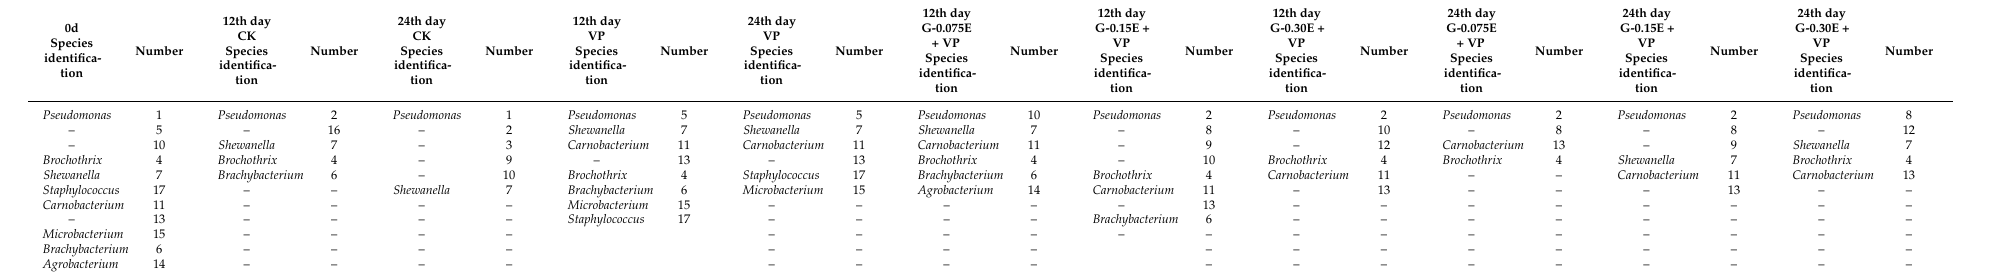
Table 4. Identification of bacteria isolated from various seabass fillet samples during cold storage at − 0.9 ◦ C using culture-dependent 16S rRNA gene sequencing